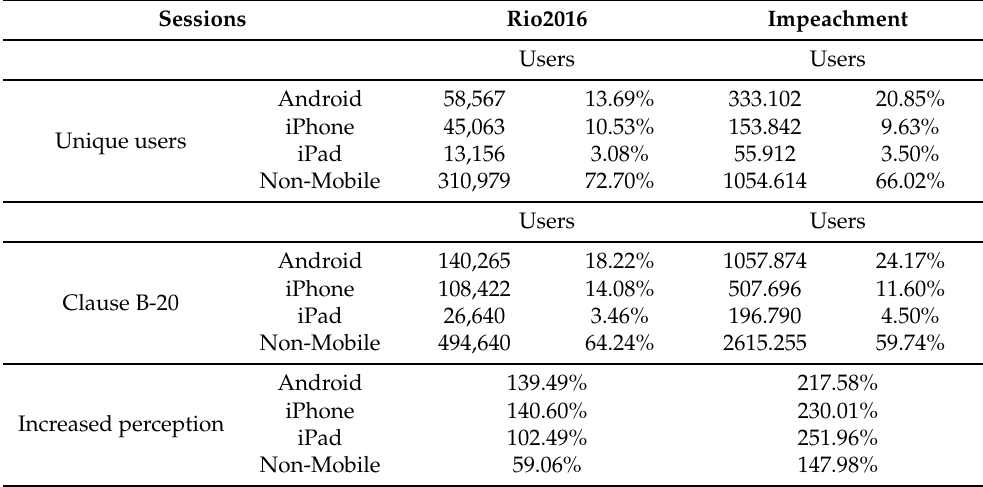
Table 2. Increased user perception considering Clause B—20 s.